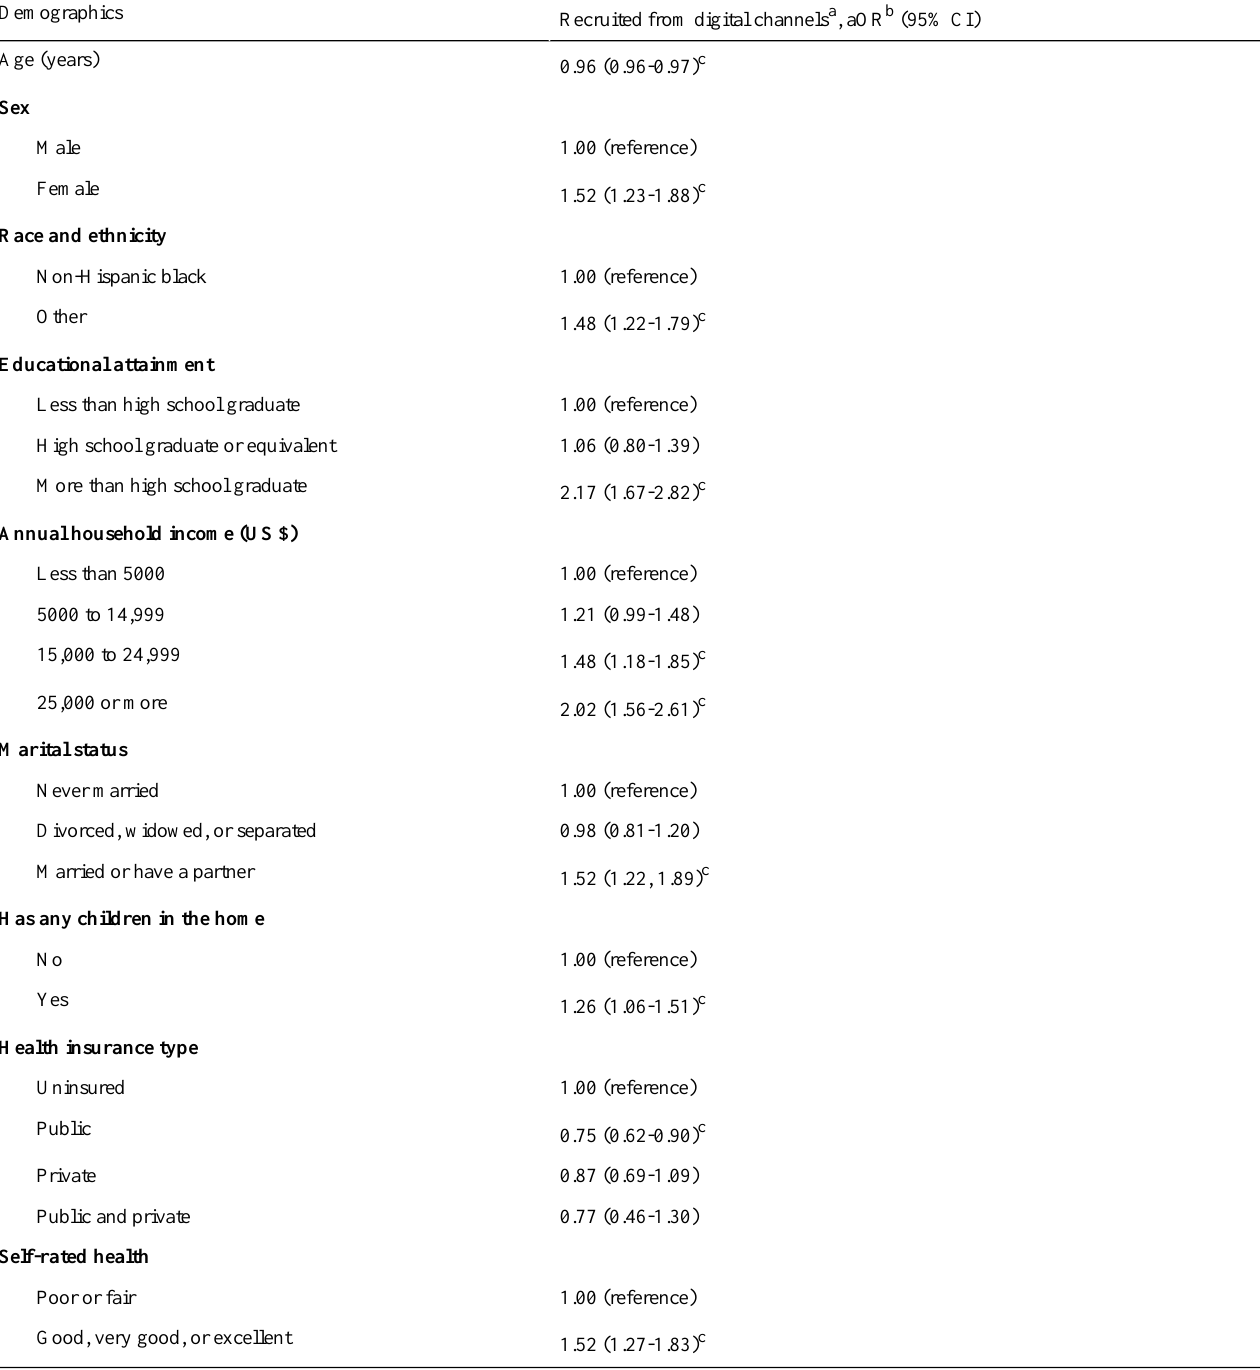
Table 2. Logistic regression model for characteristics associated with recruitment channel type, using phone as the reference